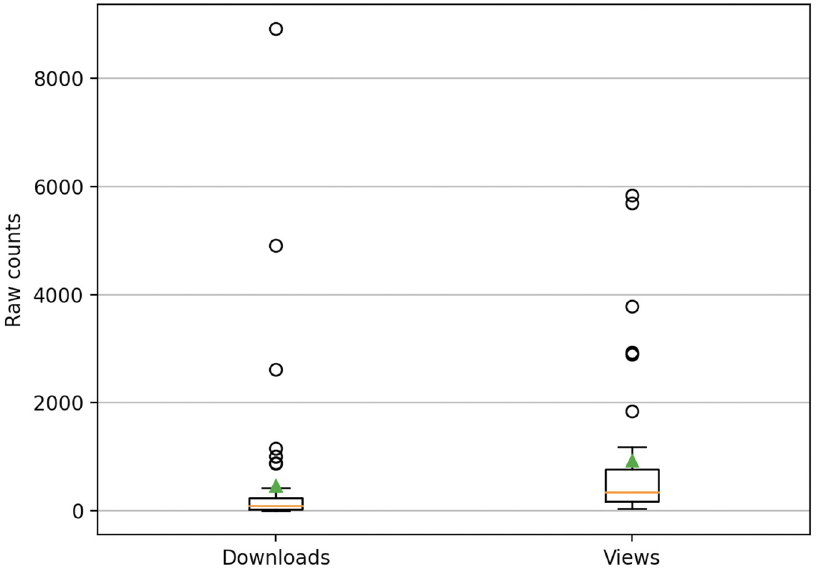
Figure A10. Datasets associated with JOHD/RDJ data papers: average total downloads and views.